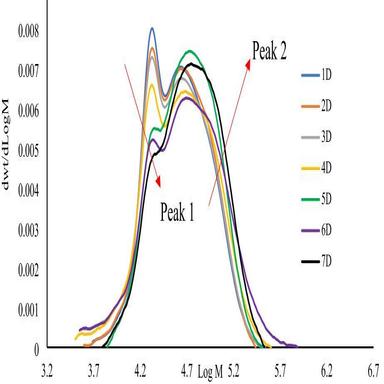
Normalized MWD evolution of conjugate mixtures using Process C (different reaction time) after purification by Dialysis b.